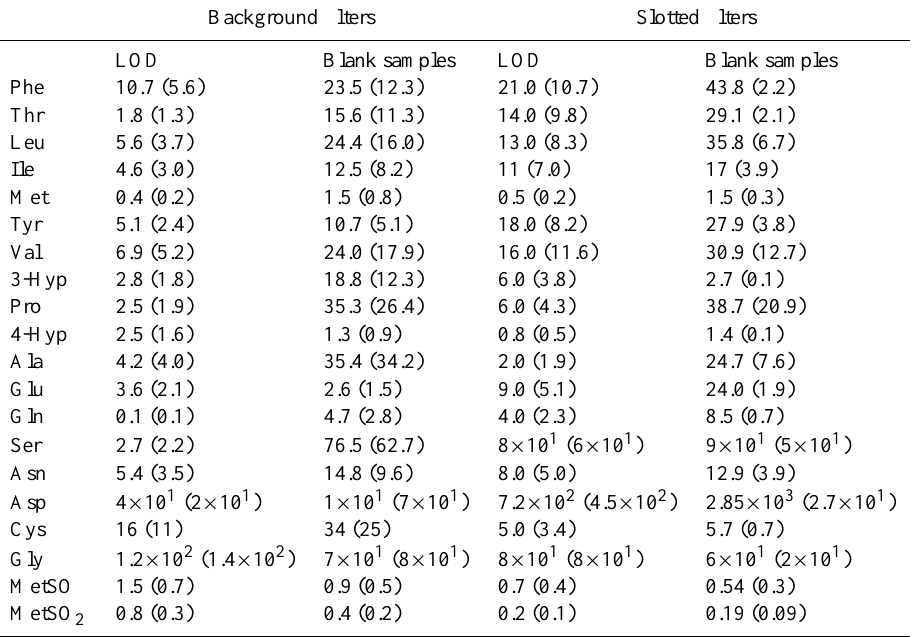
Table 1. Limits of detection (LOD),ng (fmolm − 3 ), of single amino compounds in aerosol samples and average concentration in the blank samples, ng (fmolm − 3 ).